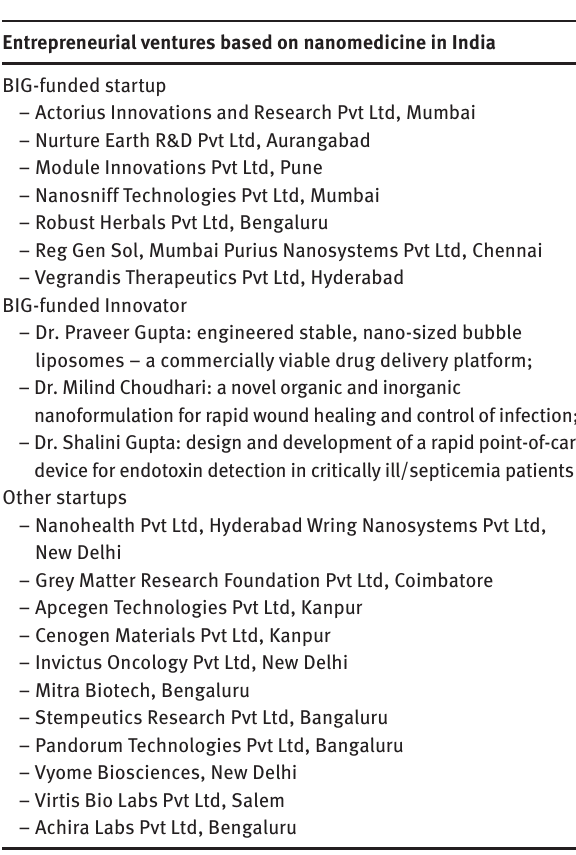
Table 7: A list of entrepreneurial ventures in India in nanomedicine (source: compiled by authors from different